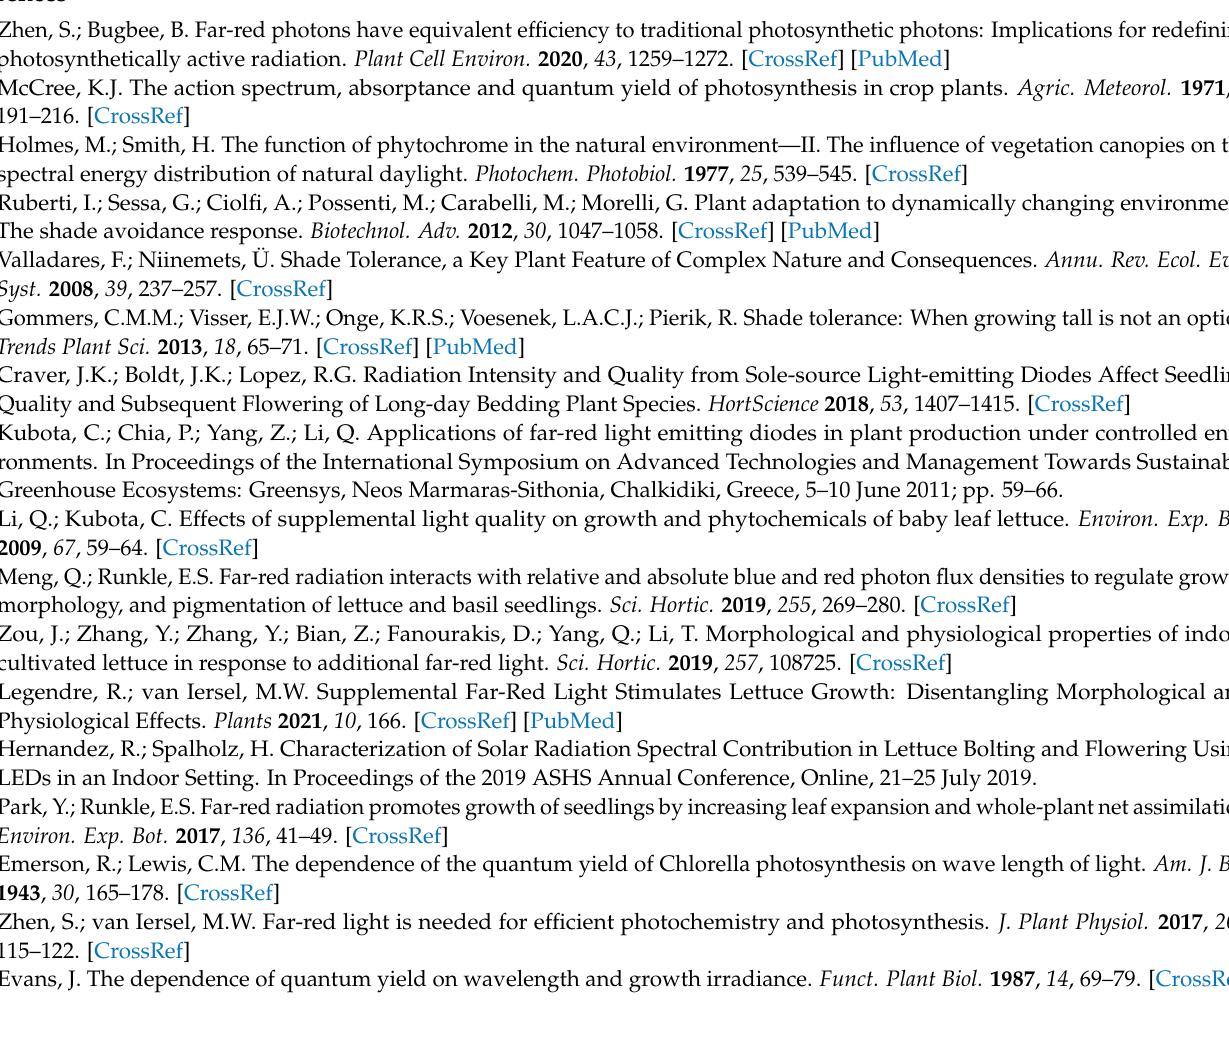
graphs and are shown with the respective color; Figure S12: With a background of 204 µ mol · m − 2 · s − 1 white LED light, supplemental far-red photons linearly increased shoot fresh weight at 20 days after the start of far-red light treatment for ‘Cherokee’, but not for ‘Green Saladbowl’ (blue triangles) and ‘Little Gem’ (black dots) lettuce. The r 2 and p values for regression of each cultivar apply to both graphs and are shown with the respective color; Figure S13: With a background of 204 µ mol · m − 2 · s − 1 white LED light, supplemental far-red photons linearly increased shoot fresh weight 35 days after the start of far-red light treatment for ‘Cherokee’, but not for ‘Green Saladbowl’ (blue triangles) and ‘Little Gem’ (black dots) lettuce. The r 2 and p values for regression of each cultivar apply to both graphs and are shown with the respective color; Table S1: Details of light spectrums used in this study, including different metrics that quantify far-red light in the light